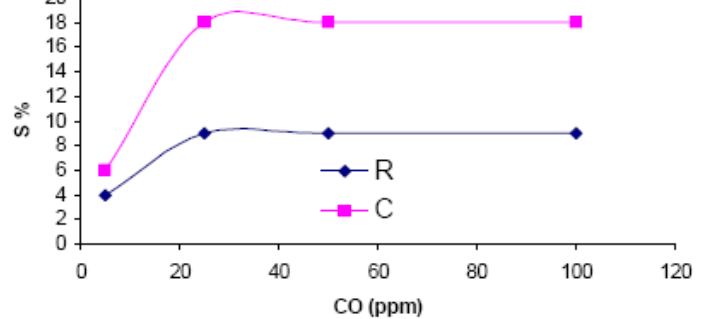
Figure 11. Response to carbon monoxide measured at 300  C and 40%